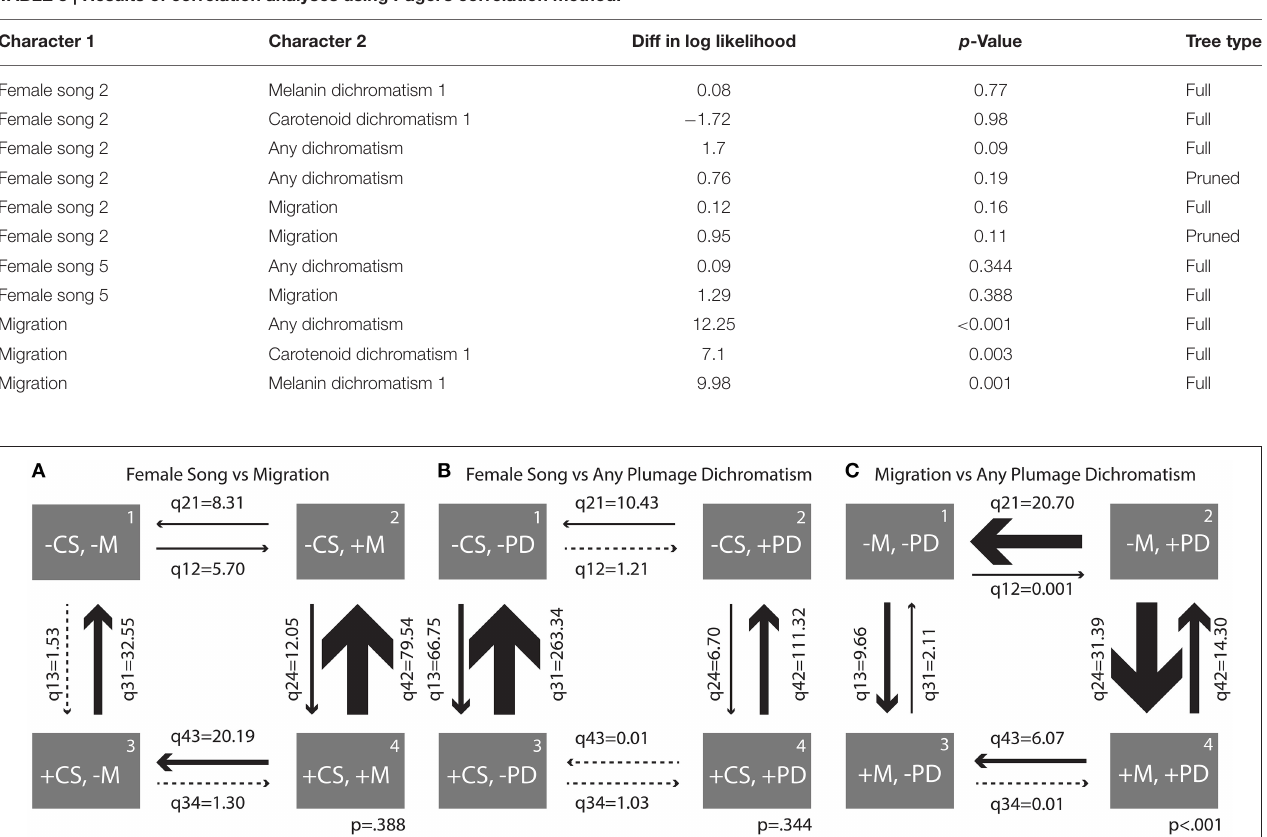
TABLE 3 | Results of correlation analyses using Pagel’s correlation method.